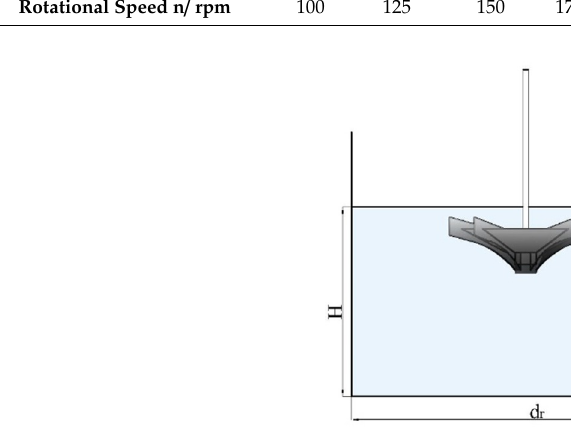
Figure 3. Diagram of aeration tank.